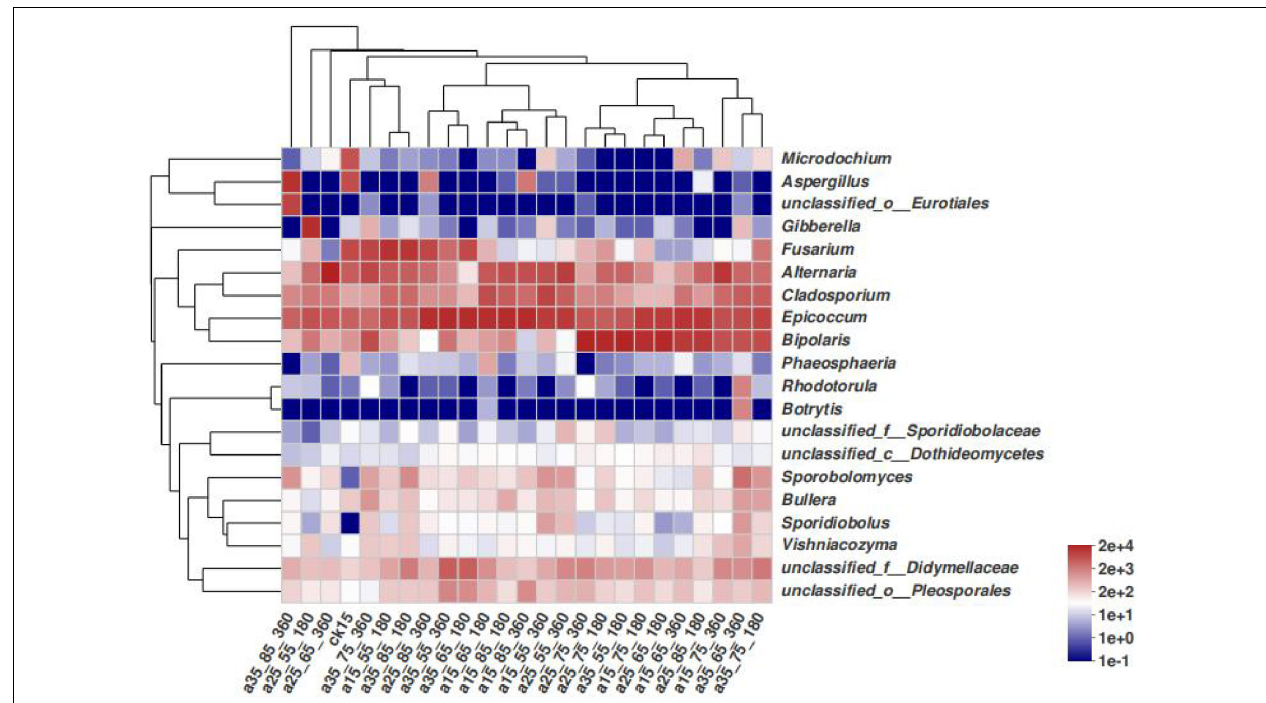
FIGURE 4 | Heatmap distribution of fungal communities in barley under different storage conditions. Heatmap analysis was performed on the top 20 species of the barley samples, representing the abundance of different species in the sample by the color block color gradient.